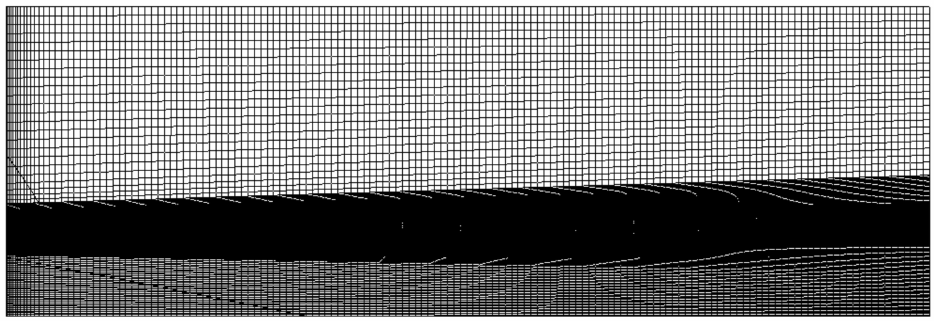
Figure 5. Mesh along center plane for symmetry model jet domain.